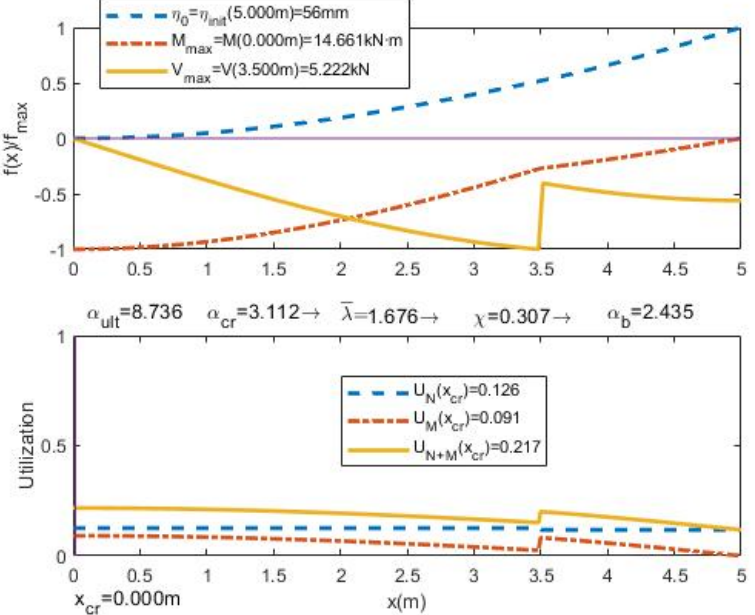
which are the same.